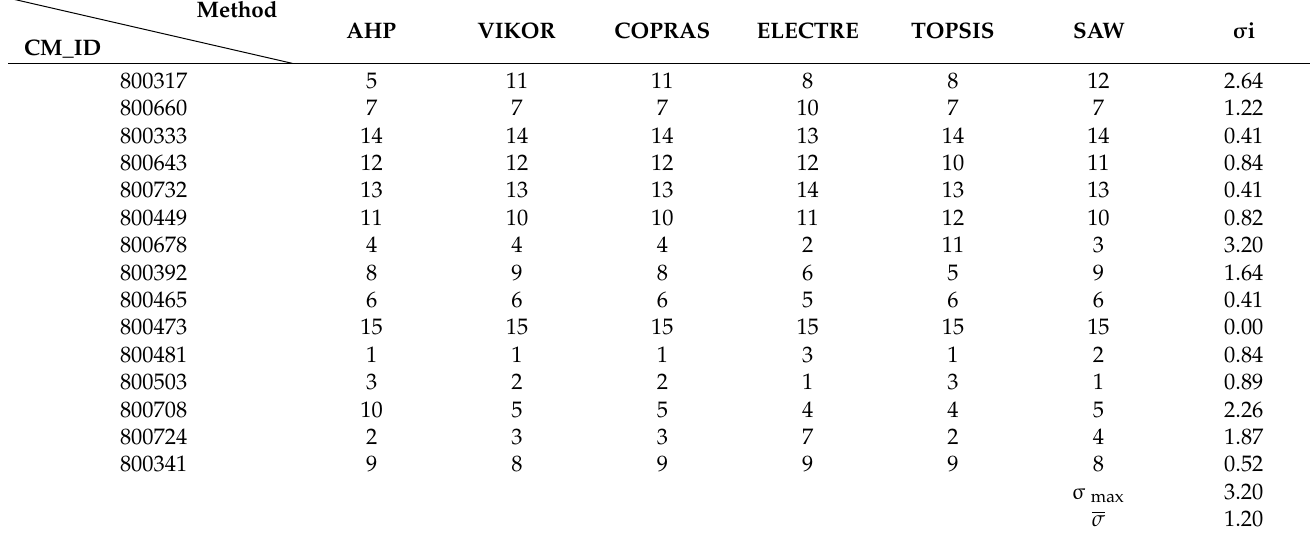
Table 9. Ranking lists and standard deviations of alternative ranks with ten